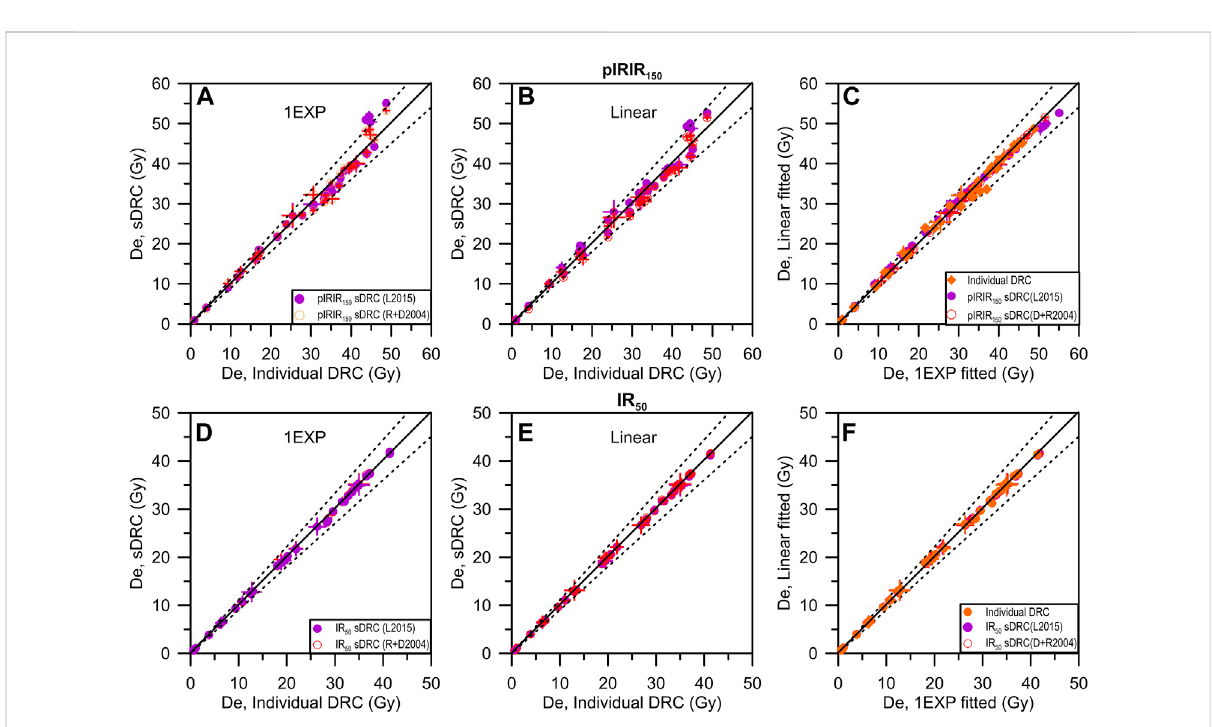
FIGURE 6 Comparisons of D e determined by the sDRCs and the individual DRC for each sample (A) and (B) , pIRIR 150 ; (D) and (E) , IR 50 ). The D e value is presented as the mean D e of 24 aliquots for each sample. (A,D) The results determined using the 1EXP fi tted DRCs, and those determined using the linear DRCs are shown in (B,E) . (C,F) The relationship between D es determined by the 1EXP and linear fi tted